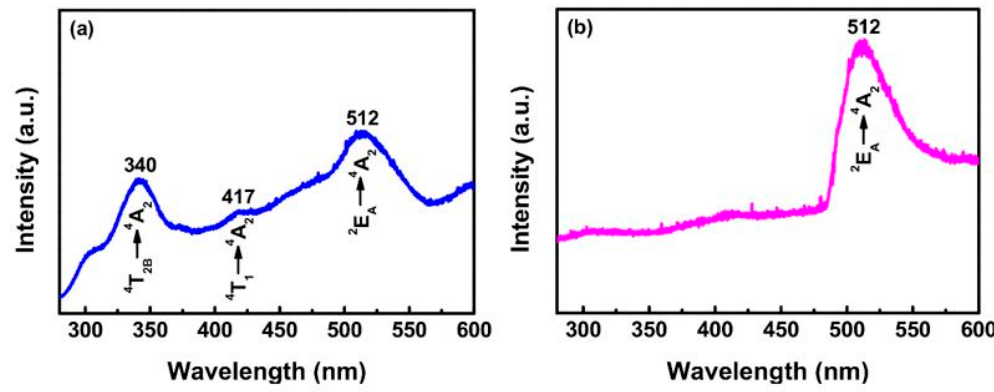
Figure 9. Room temperature PL spectra of the ZnGa 2 O 4 films deposited on: ( a ) sapphire(0001) and ( b ) Si(100) substrates [78].